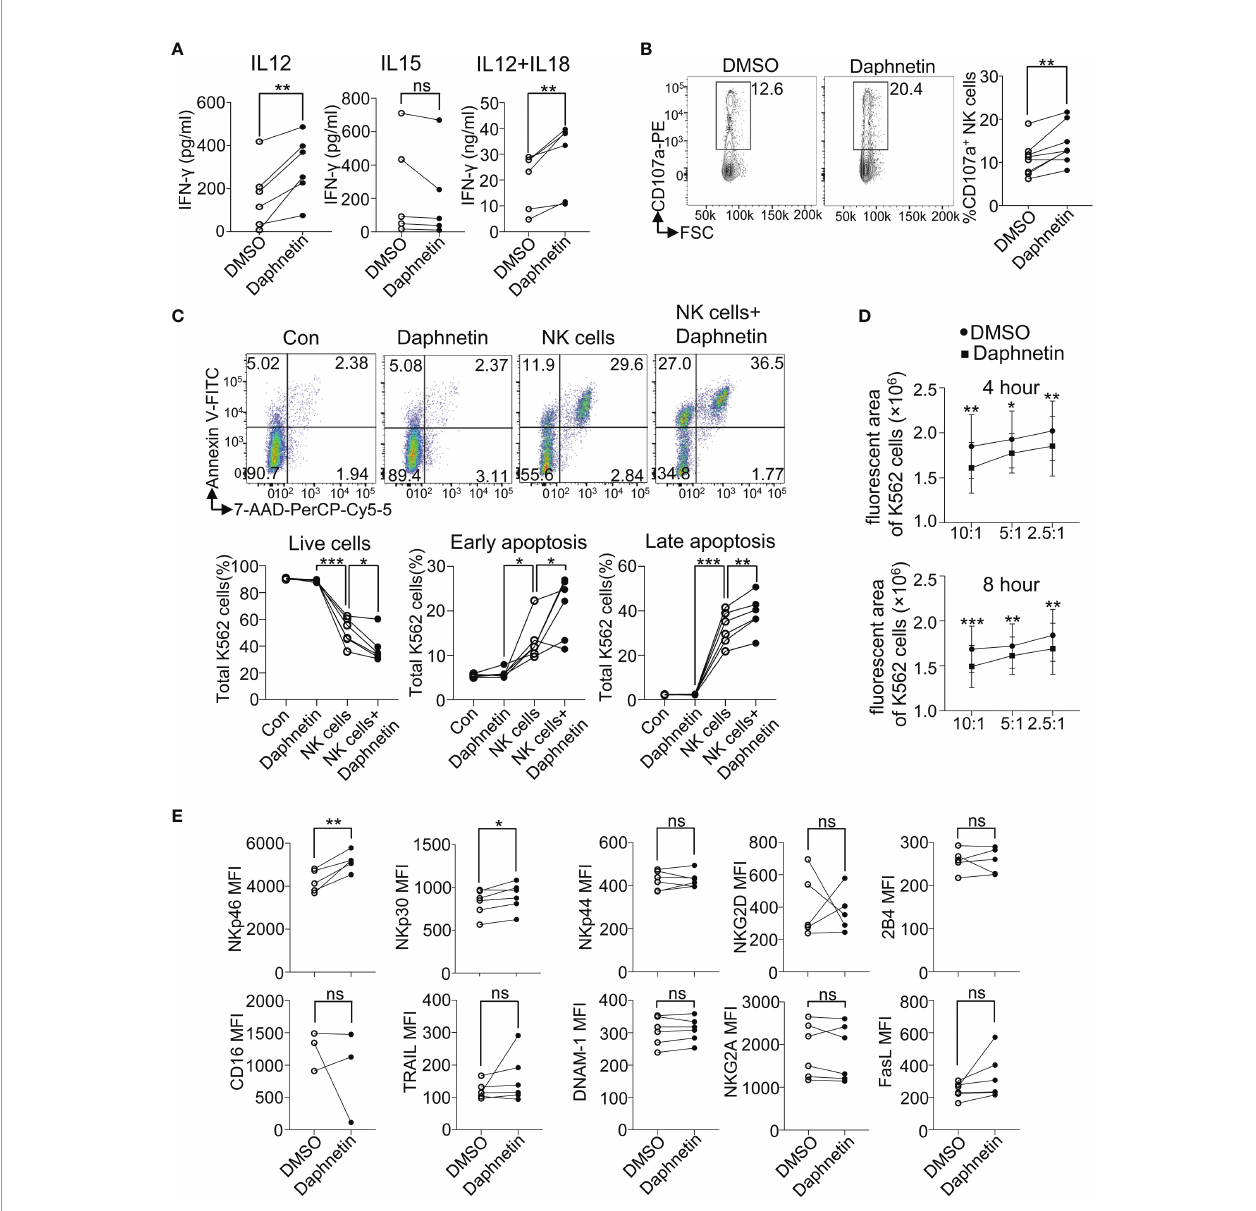
FIGURE 3 | Effects of Daphnetin on IFN- g secretion and cytotoxicity by puri fi ed human primary NK cells. (A) Puri fi ed human primary NK cells ( ≥ 99.0%) were treated with DMSO or Daphnetin for 18 h in the presence of IL-12 (10 ng/ml) (left), IL-15 (10 ng/ml) (middle), or IL-12 (10 ng/ml) plus IL-18 (10 ng/ml) (right), respectively. The levels of IFN- g in the supernatants of cell culture were detected by ELISA kit. (B) Puri fi ed human primary NK cells were treated with DMSO or Daphnetin for 18 h in the presence of IL-12 (10 ng/ml), followed by co-culture with K562 cells for another 6 h and the expression level of CD107a on NK cells were determined by fl ow cytometry. (C) The ratio of Annexin V - 7-AAD - , Annexin V + 7-AAD - , and Annexin V + 7-AAD + K562 cells was determined by fl ow cytometry after CTV-labeled K562 cells were co-cultured with puri fi ed human primary NK cells that were pre-treated with DMSO or Daphnetin in the presence of IL-12 (10 ng/ml). Annexin V - 7-AAD - represents live cells; Annexin V + 7-AAD - represents early apoptosis; Annexin V + 7-AAD + represents late apoptosis. (D) The CellTracker dye-labeled K562 cells were imaged by living cell microscopic imaging system after CellTracker dye-labeled K562 cells were co-cultured with puri fi ed human primary NK cells treated that pretreated with DMSO or Daphnetin in the presence of IL-12 (10 ng/ml) at the indicated time point. The fl uorescent area of K562 cells was recorded and further analyzed using Gen5 ™ software. (E) Puri fi ed human primary NK cells ( ≥ 99.0%) were treated with DMSO or Daphnetin in the presence of IL-12 (10 ng/ml) for 18 h and the expression of NK activating and inhibitory receptors were detected by fl ow cytometry. Each dot represents one donor. Paired t -test for (B – E) . * p < 0.05, ** p < 0.01, *** p < 0.001, and ns (not statistically signi fi cant) denote statistical comparison between the two marked treatment groups (B – E)